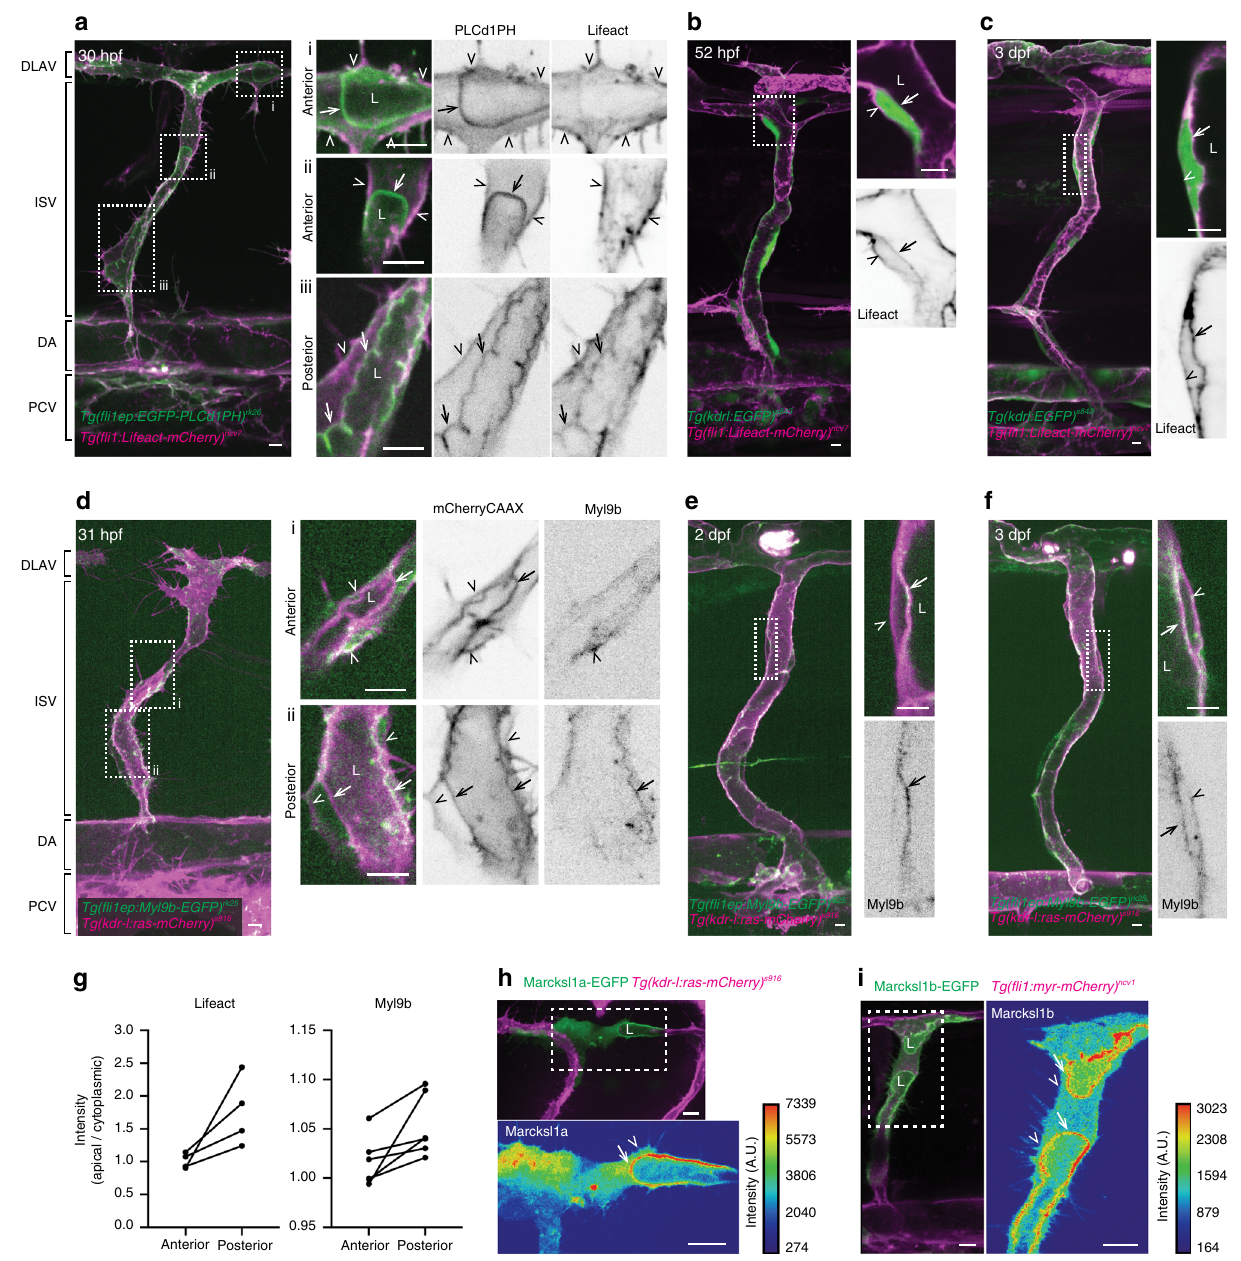
Fig. 1 Low actomyosin at endothelial cell apical cortex coincides with lumen expansion. a – f Maximum intensity projection of confocal z-stacks of trunk vessels at different stages of zebra fi sh development. Cropped images are single-plane images of the z-stack. During lumen expansion of ISVs from 30 to 34 hpf embryos, higher levels of actin ( a , Lifeact) and non-muscle myosin II ( d , Myl9b) are assembled at the apical cortex of the posterior region of the lumen (iii in a , ii in d ) compared to the expanding anterior region of the lumen (i and ii in a , i in d ), which contains very little or no actomyosin. At 2 and 3 dpf, distinct actin ( b , c ) and non-muscle myosin II ( e , f ) are detected in the apical cortex of fully lumenised vessels. Images are representative of 6 ( a , n = 2 independent experiments), 9 ( b , n = 5 independent experiments), 7 ( c , n = 4 independent experiments), 23 ( d , n = 3 independent experiments), 8 ( e , n = 3 independent experiments) and 4 ( f , n = 2 independent experiments) embryos. g Quanti fi cation of apical Lifeact and Myl9b intensity levels in the anterior and posterior segments of the same lumen at 30 – 34 hpf. Each data pair represents one ISV (Lifeact: n = 4 ISVs from 4 embryos; Myl9b: n = 6 ISVs from 5 embryos). h , i Single-cell expression of Marcksl1a-EGFP in 34 hpf Tg(kdr-l:ras-mCherry) s916 embryo ( h , apical enrichment was observed in 5 out of 5 embryos from 3 independent experiments) and Marcksl1b-EGFP in 38 hpf Tg( fl i1:myr-mCherry) ncv1 embryo ( i , apical enrichment was observed in 20 out of 20 embryos from 6 independent experiments). Arrows, apical cortex; arrowheads, basal cortex; dashed boxes, the magni fi ed regions; DA dorsal aorta; DLAV dorsal longitudinal anastomotic vessel; ISV intersegmental vessel; L lumen; PCV posterior cardinal vein. Scale bars, 5 µ m ( a – f ) and 10 µ m ( h , i ). Source data are provided as a Source data fi